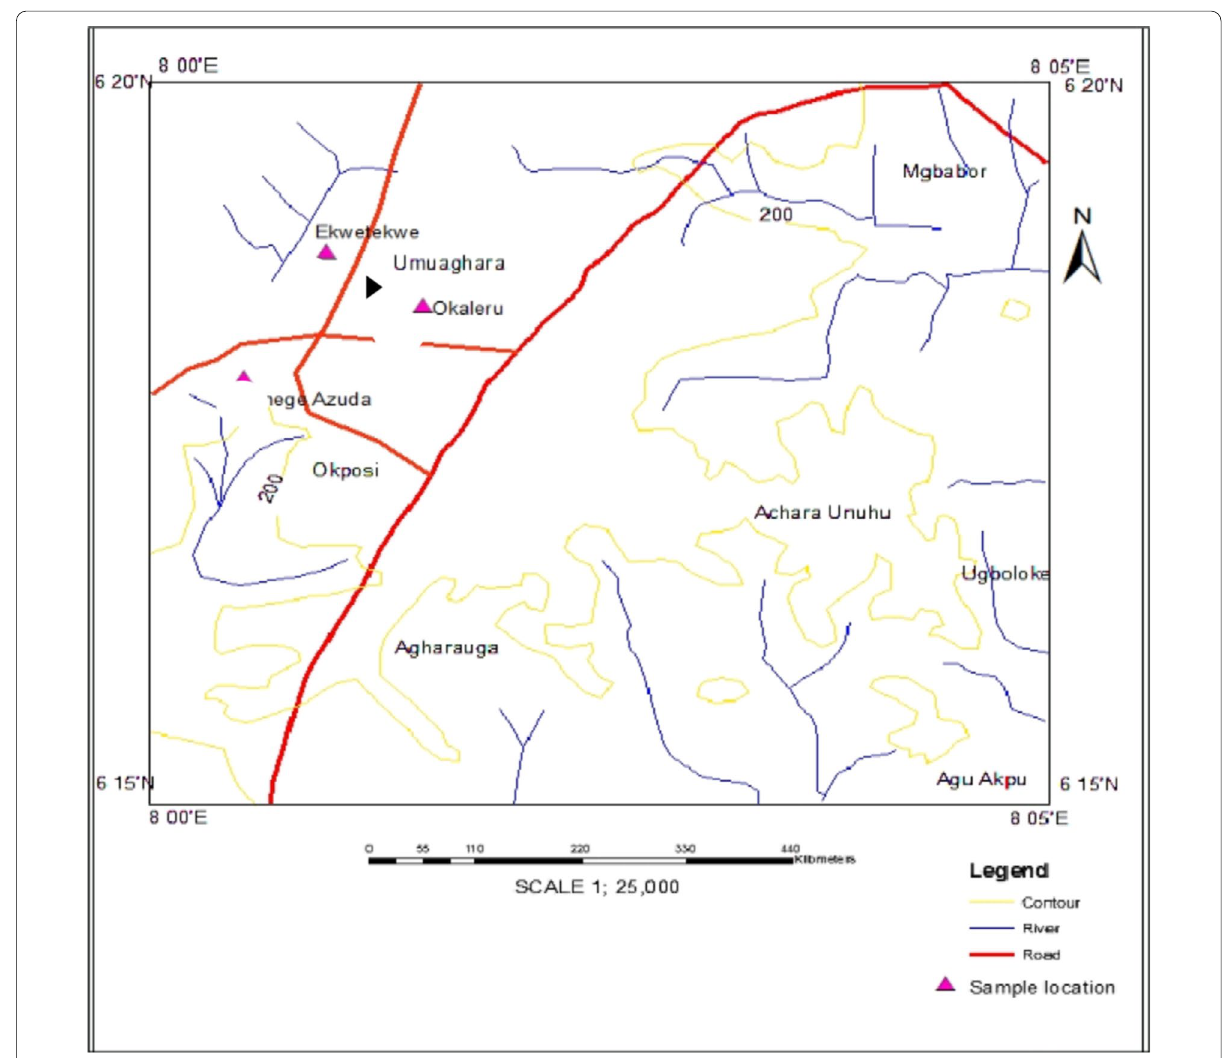
values of 17.25 and 15.00, respectively, at 500 mg/l.